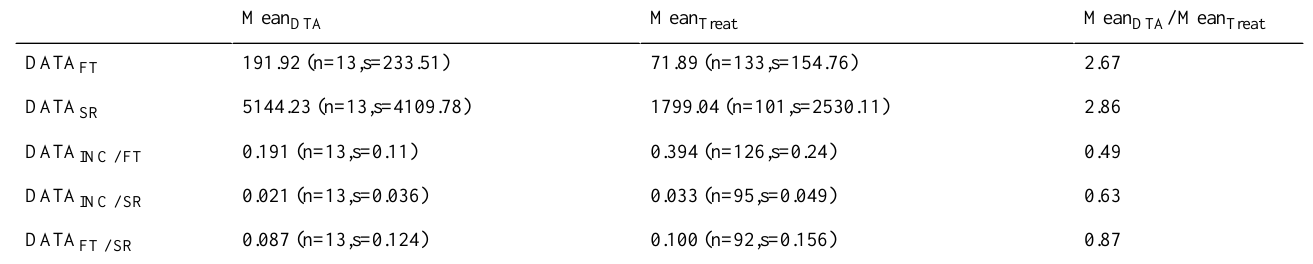
Table 5. Summary of mean values for collected statistics.